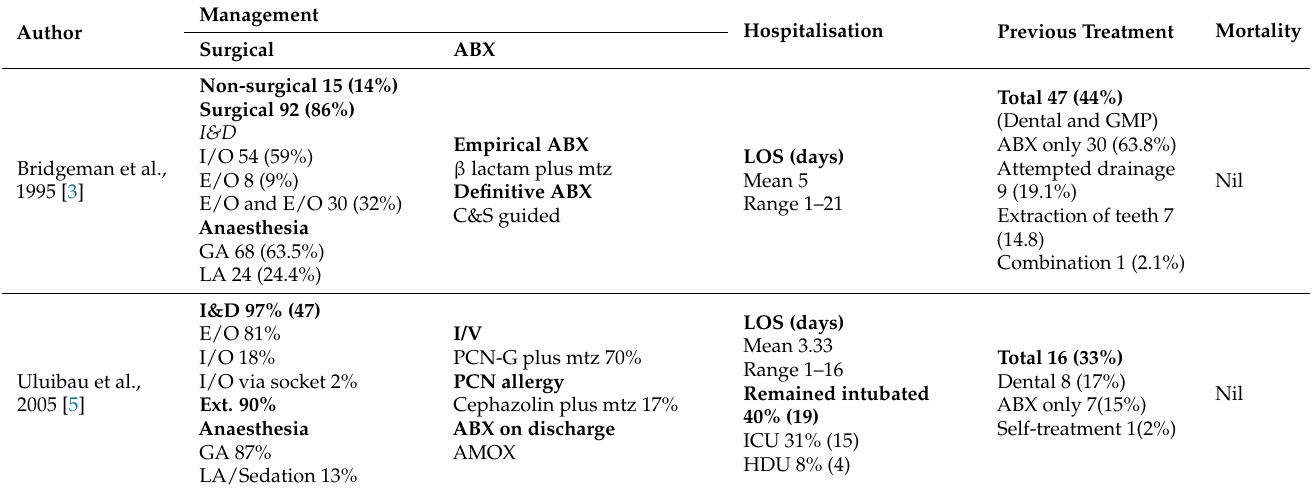
Table 3. Management, hospitalisation, previous treatment and mortality associated with dental